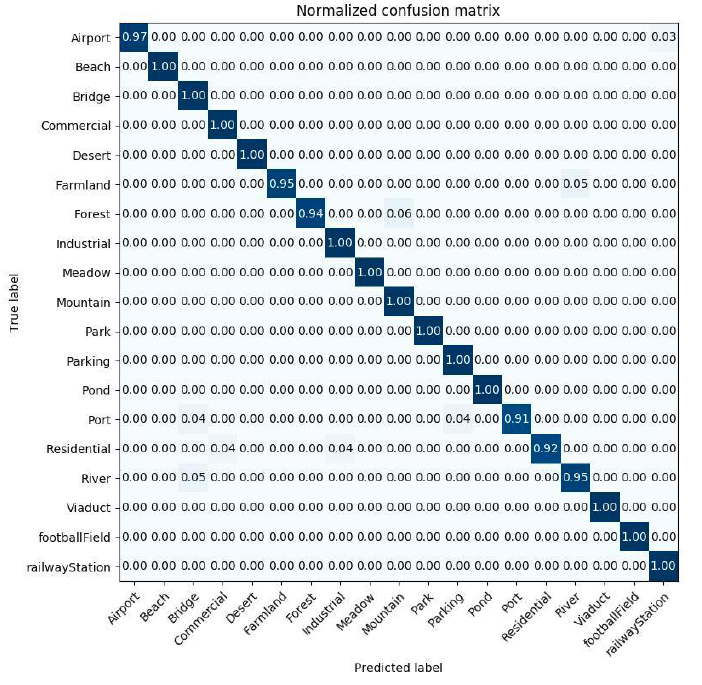
Figure 11. The confusion matrix of the examined method, with 60% of WHU-RS dataset as a training set for InceptionV3 mixed_8 (PCA) + ResNet50 average pooling.